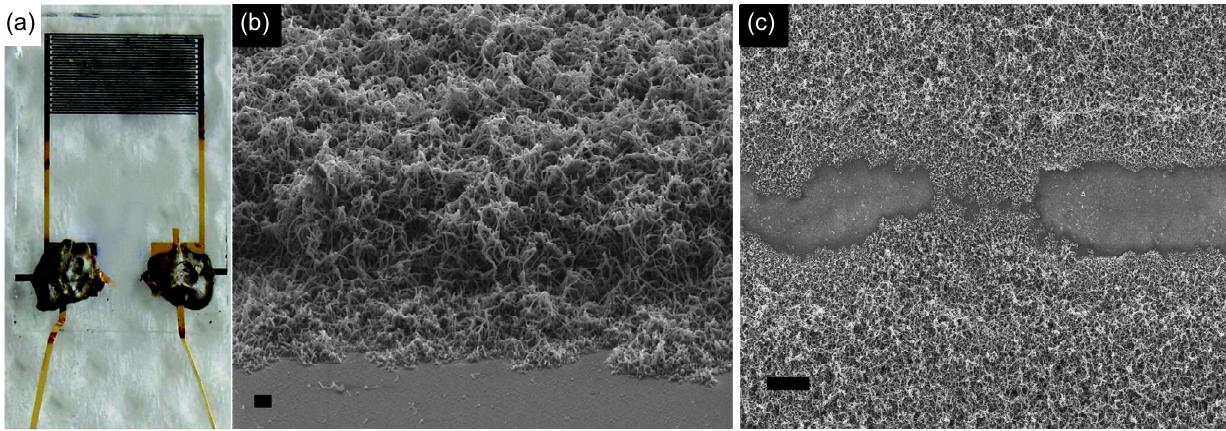
Figure 6. ( a ) Photograph of a developed gas sensor electrode. SEM images of PPy nanowires deposited on the electrode substrate: ( b ) 65° tilted view (scale bar = 1 μ m) and ( c ) top view showing PPy nanowires bridging the insulating gap between the gold electrodes (scale bar = 10 μ m). With permission from [52]; Copyright 2012, American Chemical